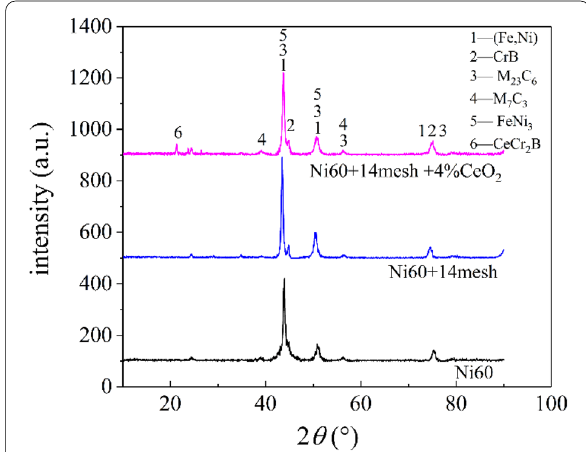
Figure 10 XRD phase diagram of nickel-based composite